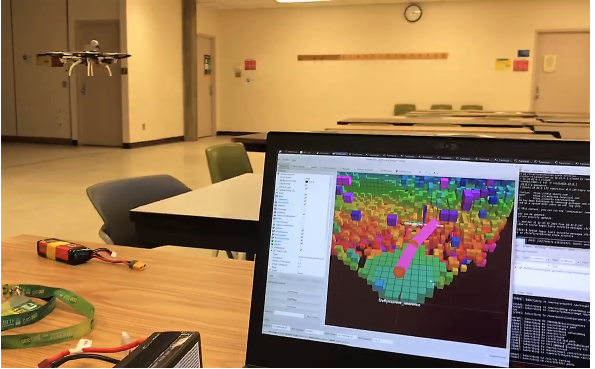
Figure 16. Preliminary flight test.